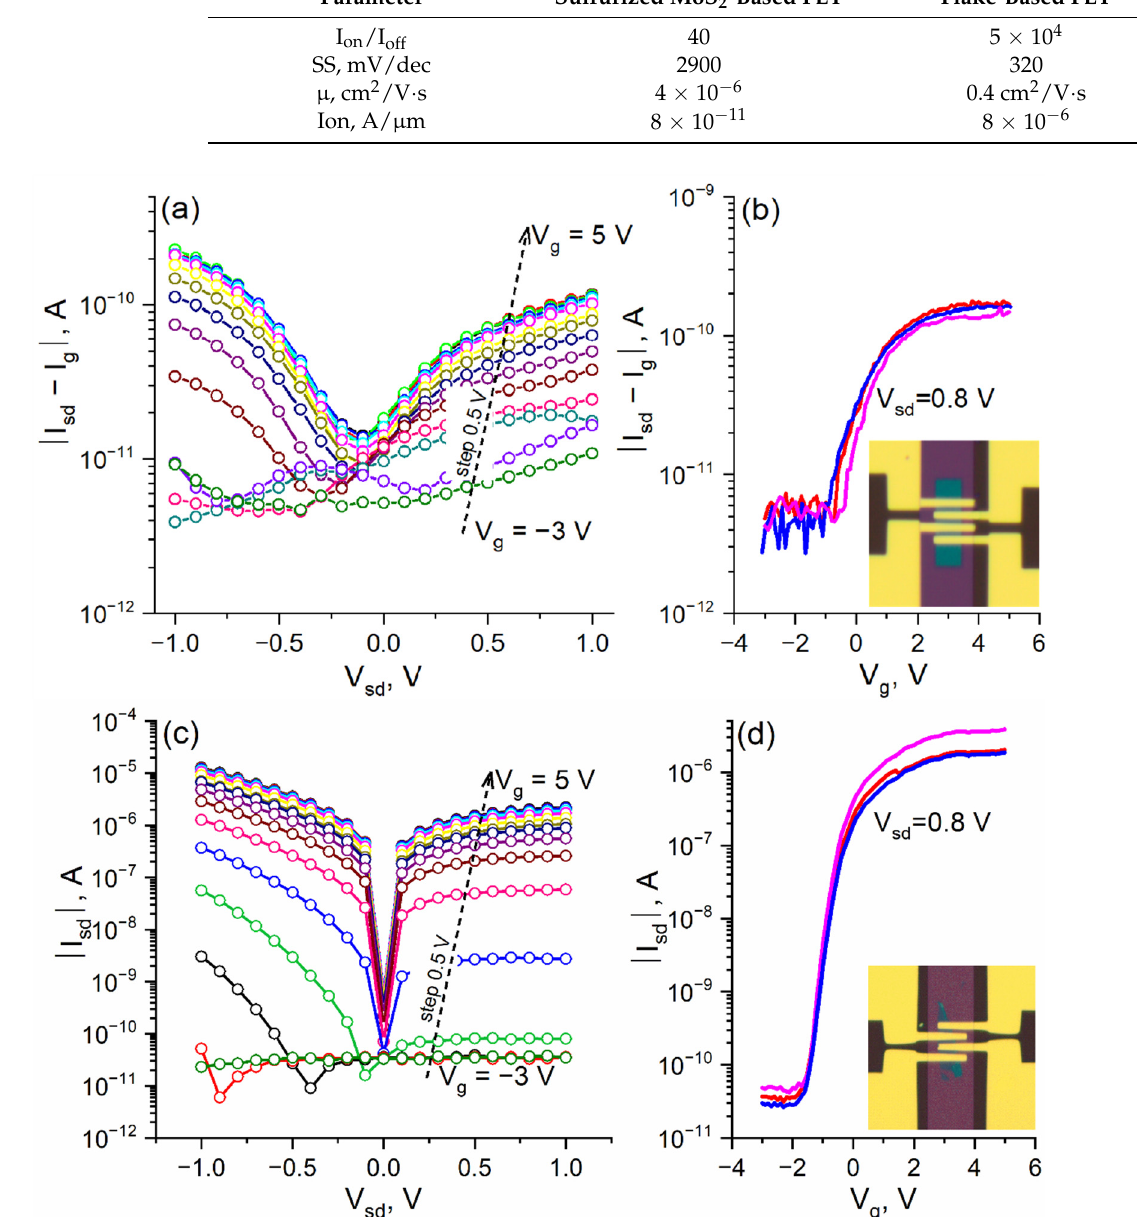
Figure 6. DC-IV source-drain characteristics of FETs based on sulfurized ( a ) and flake ( c ) MoS 2 with a channel length of 1 µm measured at different gate voltages; transfer characteristics ( b , d ) of mentioned FETs (different colors correspond to nominally identical structures) measured at V sd = 0.8 V (inset: Optical image of the FET).